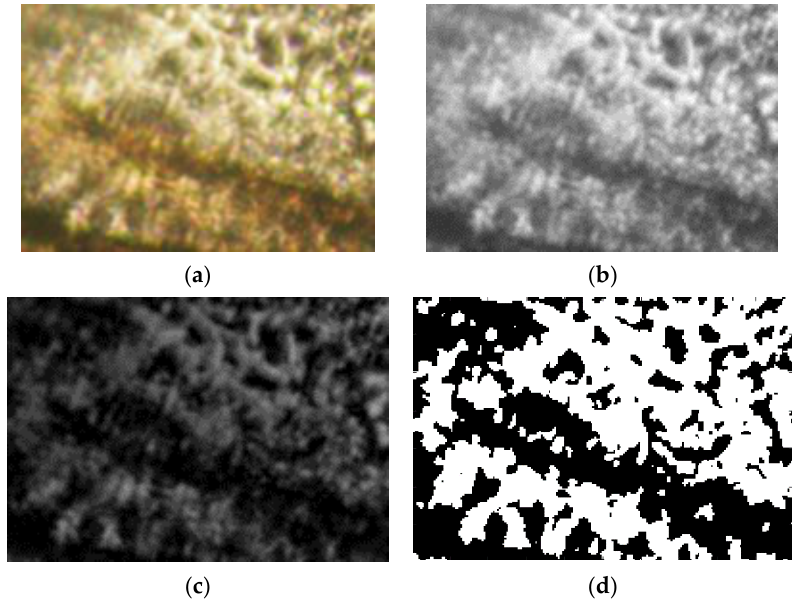
Figure 15. Primary processing of the selected image U 4 . ( a ) — original image (the entire portion); ( b ) — the grayscale version; ( c ) — the gray scale version without luminance; ( d ) — binarized version. A threshold of 35 was used for binarization.